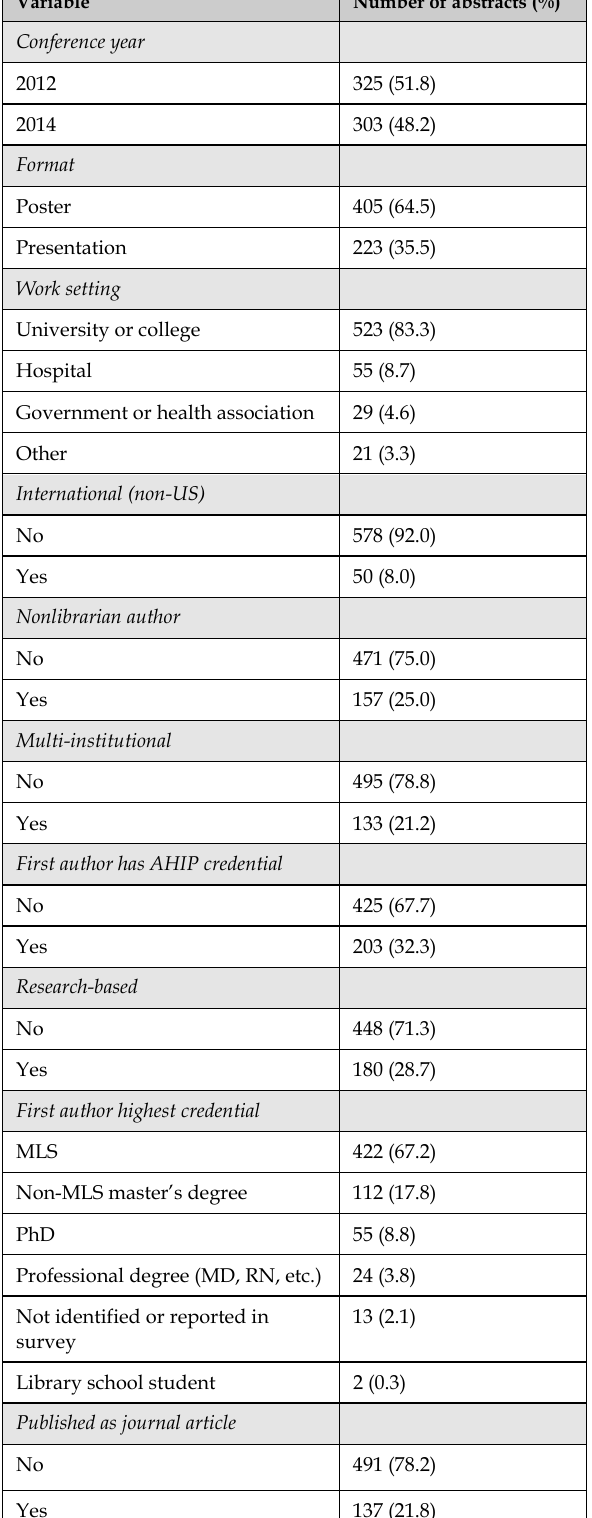
Table 1 Abstract characteristics